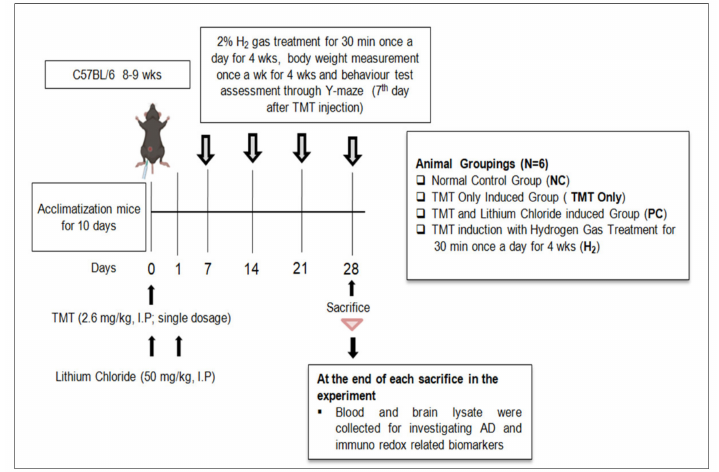
Figure 1. Schematic diagram of the experimental